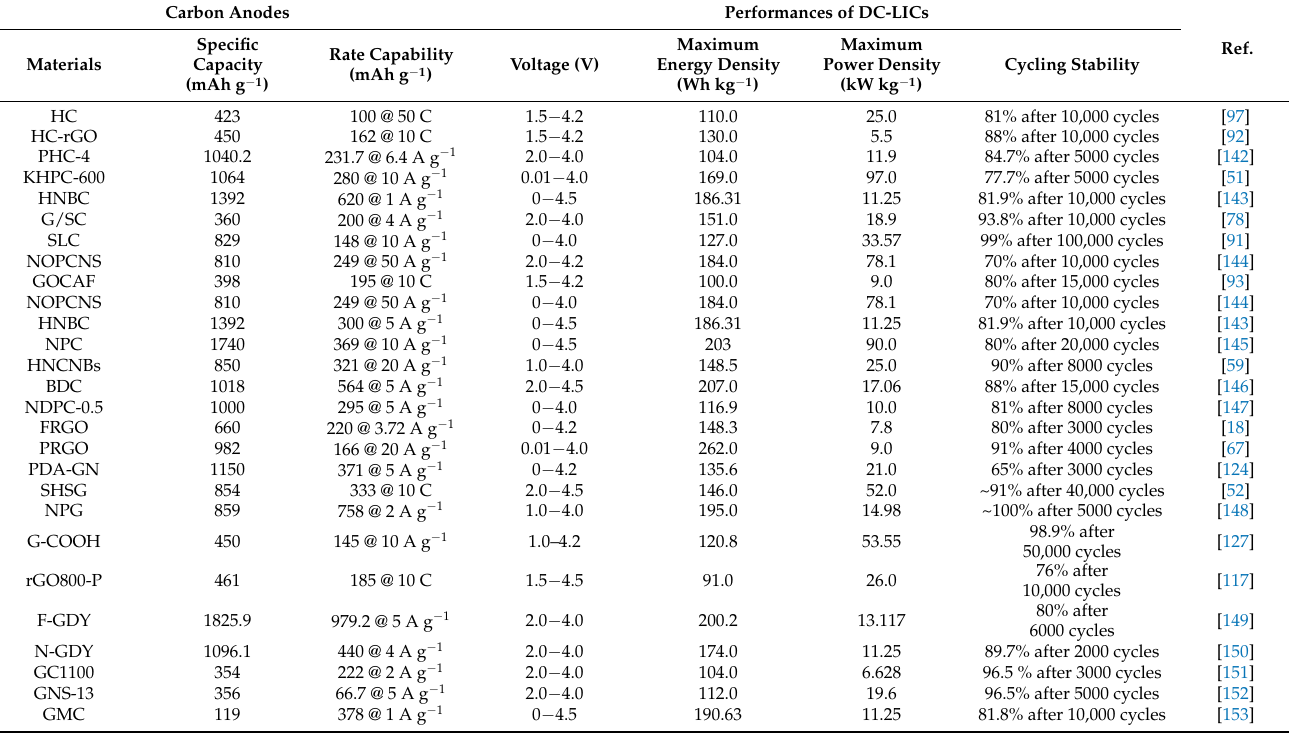
Table 2. Typical carbon anodes and the electrochemical performances of